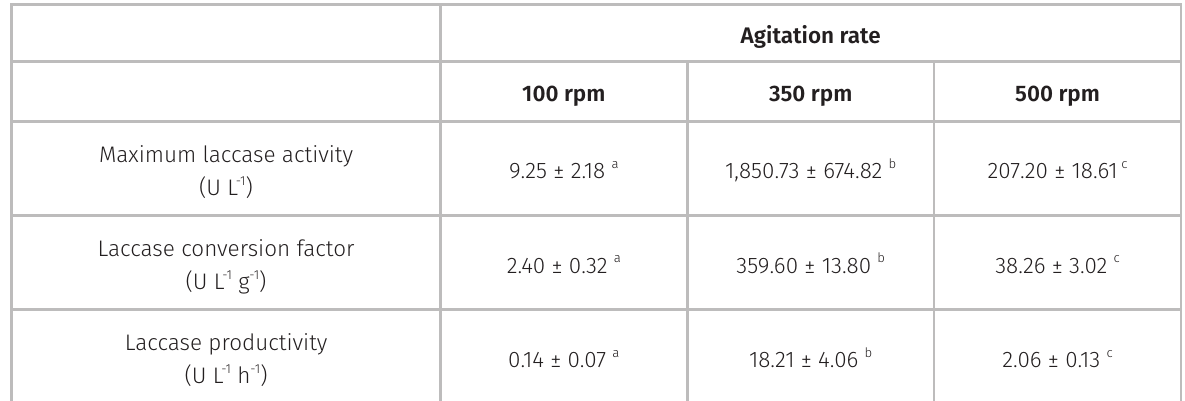
Table II. Kinetic parameters of the assays using agitations rate 100, 350 and 500 rpm (mean value ± standard